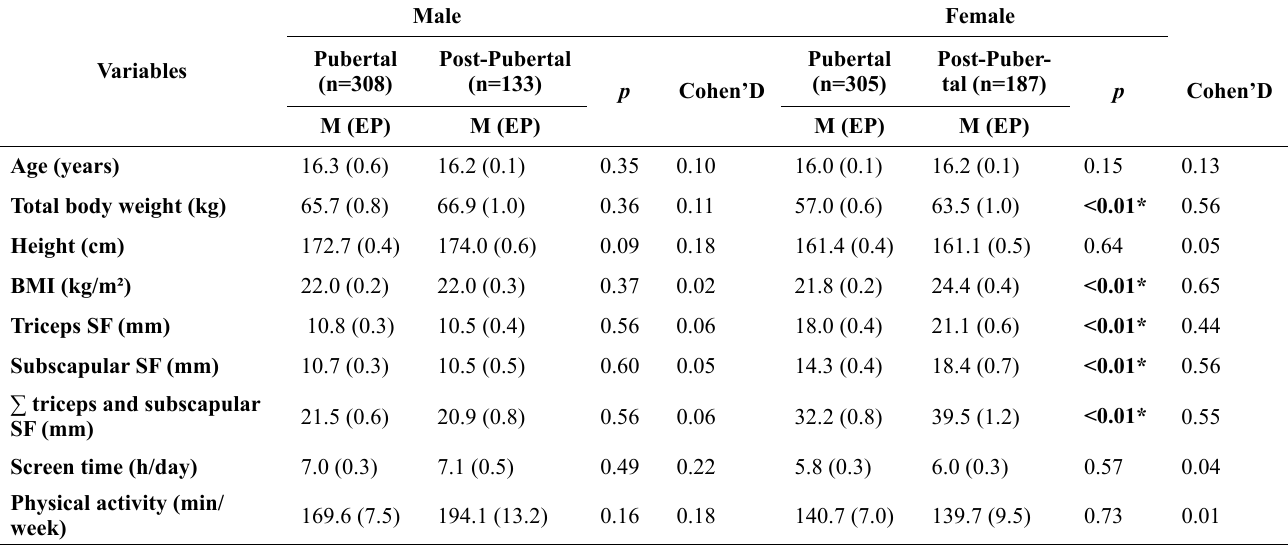
Table 2. Distribution of variables investigated by sex according to stages of maturational development of adolescents.